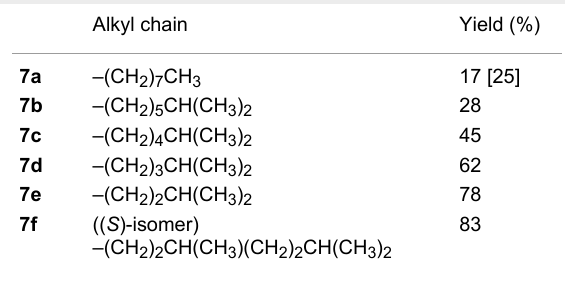
Table 1: Isolated yields of purified phthalocyanine (chromatographed, and in the case of 7a – 7e crystallised) obtained by treating the corres- ponding phthalonitrile 6 for ca. 16 h with lithium pentoxide in refluxing pentanol. For α -alkylated phthalocyanines with n -alkyl substituents, the average yield obtained by this route is 22 ± 5% (based on the fourteen known examples)